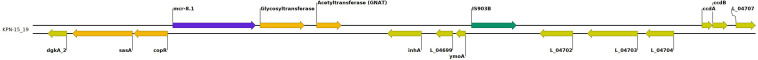
Genetic organisation of pKPN-15 and pKPN-19 harbouring mcr-8.1 gene.